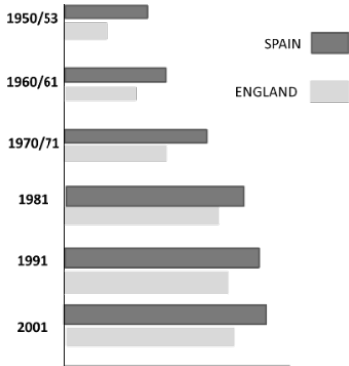
Figure 14. Comparative evolution between rent houses/bought houses and Spain vs.